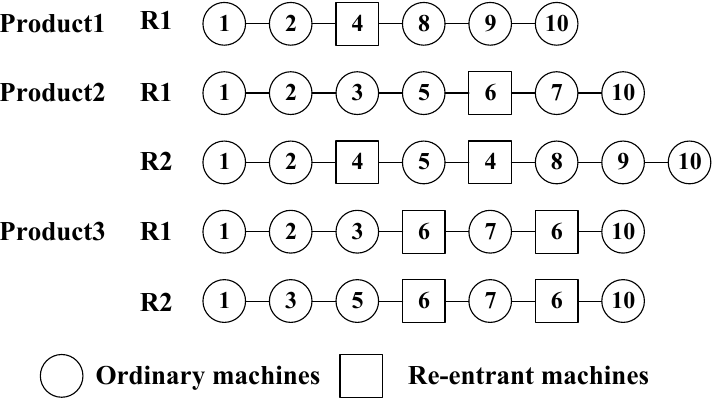
Fig. 4. Processing flow for Case